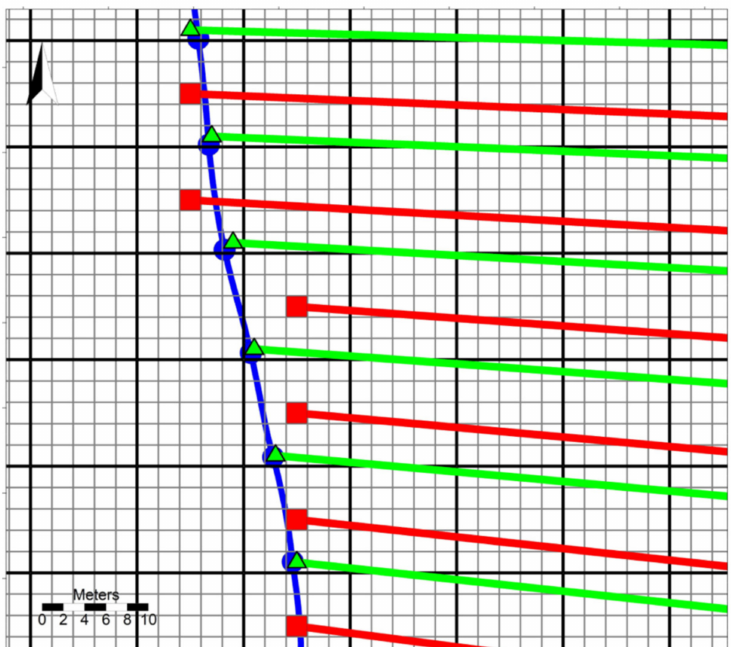
Figure 5. Illustration of how DEM raster resolution (or grid size) affects the transect start location on CliffMetrics. The baseline is shown as a blue line, with baseline points shown as blue dots. Two different grids are shown in solid black (10-meter cell grid size) and gray (2-meter cell grid size). The start of the transects delineated by CliffMetrics is shown as red squares/green triangles for the 10 m/2 m grid cell size. Red and green solid lines are the transects obtained for the 10-meter and 2-meter grid cell sizes,